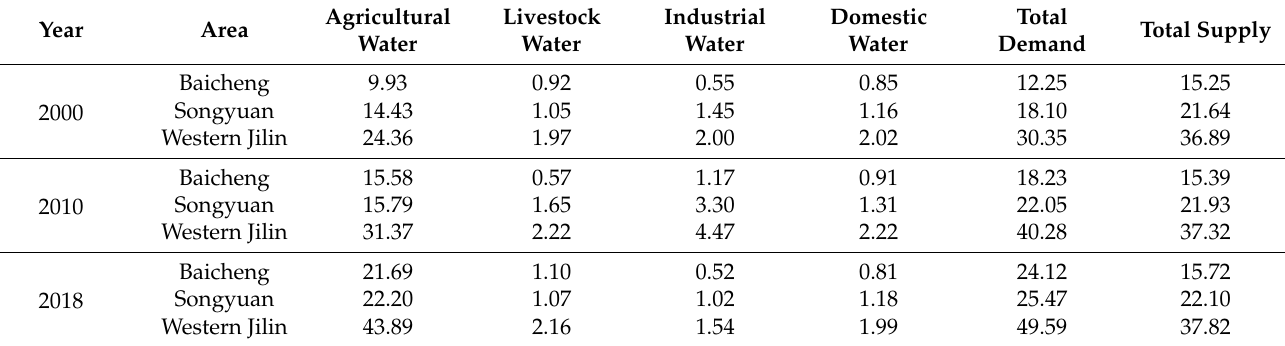
Table 4. Quantification of water supply and demand in western Jilin (10 8 m 3 ).